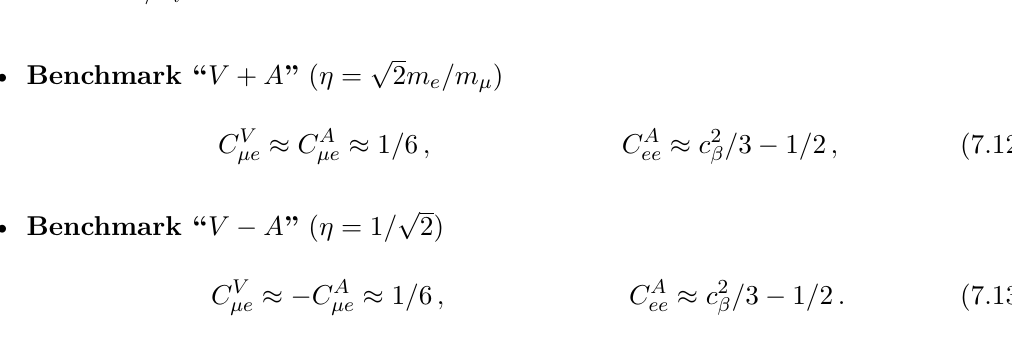
Figure 9 . Present and expected future bounds on f a and m a for the LFV QCD axion in the three scenarios described in detail in the text, see also table 3 and eqs. (7.11)–(7.13). On the lower axis we indicate the corresponding values for the effective axion mass defined by m 4 . 7 eV × 10 6 GeV /F i